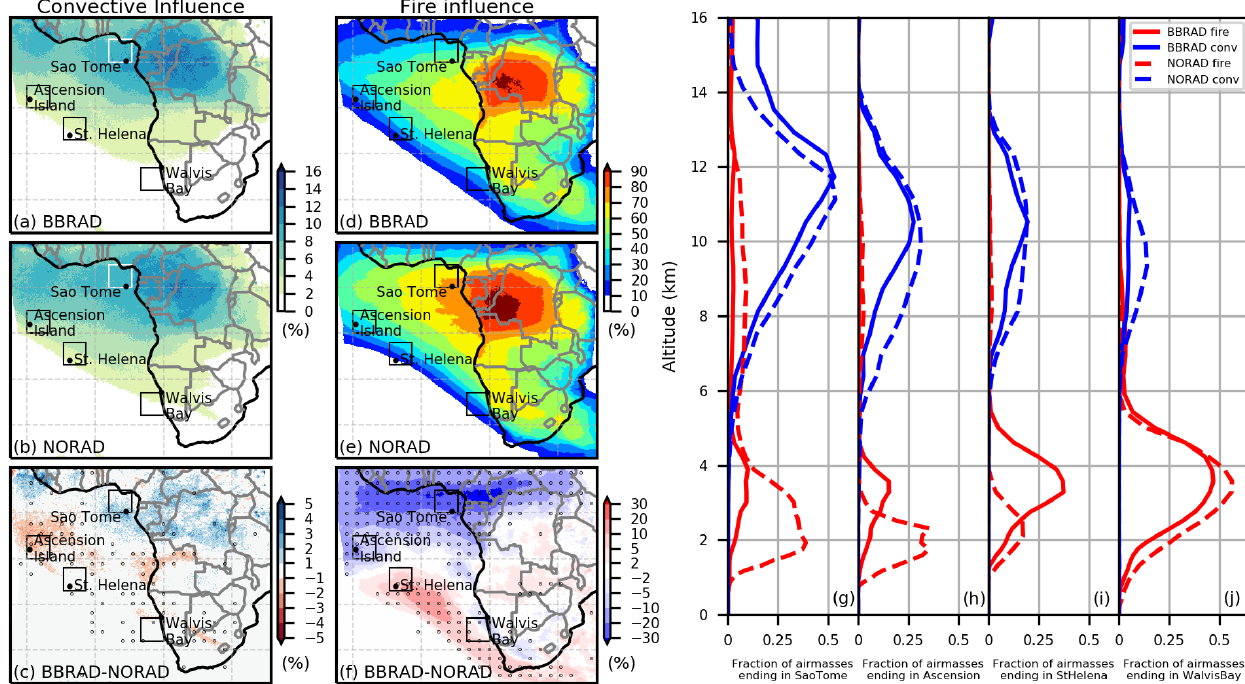
Figure 12. Left column: fraction of air masses having (a–b) convective influence and (d–e) fire influence between 0 and 16km in the last 7d for (a, d) BBRAD, (b, e) NORAD and (c, f) their changes. In panels (c) and (f) , black dots indicate where changes are statistically significant at the 0.05 level. Right column: profiles of convective (blue) and fire (red) influences at the (g) São Tomé, (h) Ascension, (i) St. Helena and (j) Walvis Bay areas for BBRAD (solid) and NORAD (dashed). Results are averaged from 7 d trajectories ending at 12:00UTC every day between 8 and 16 September 2017.